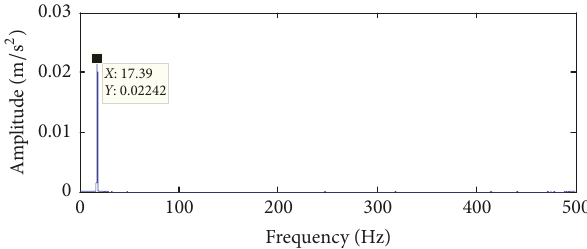
Figure 4: First-order IMF component marginal spectrum of node 15 in the derrick steel